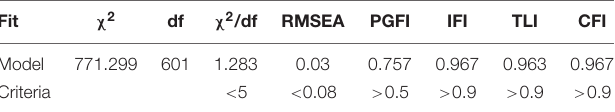
TABLE 4 | Fitting index of competitive advantage measurement model ( N = 317).